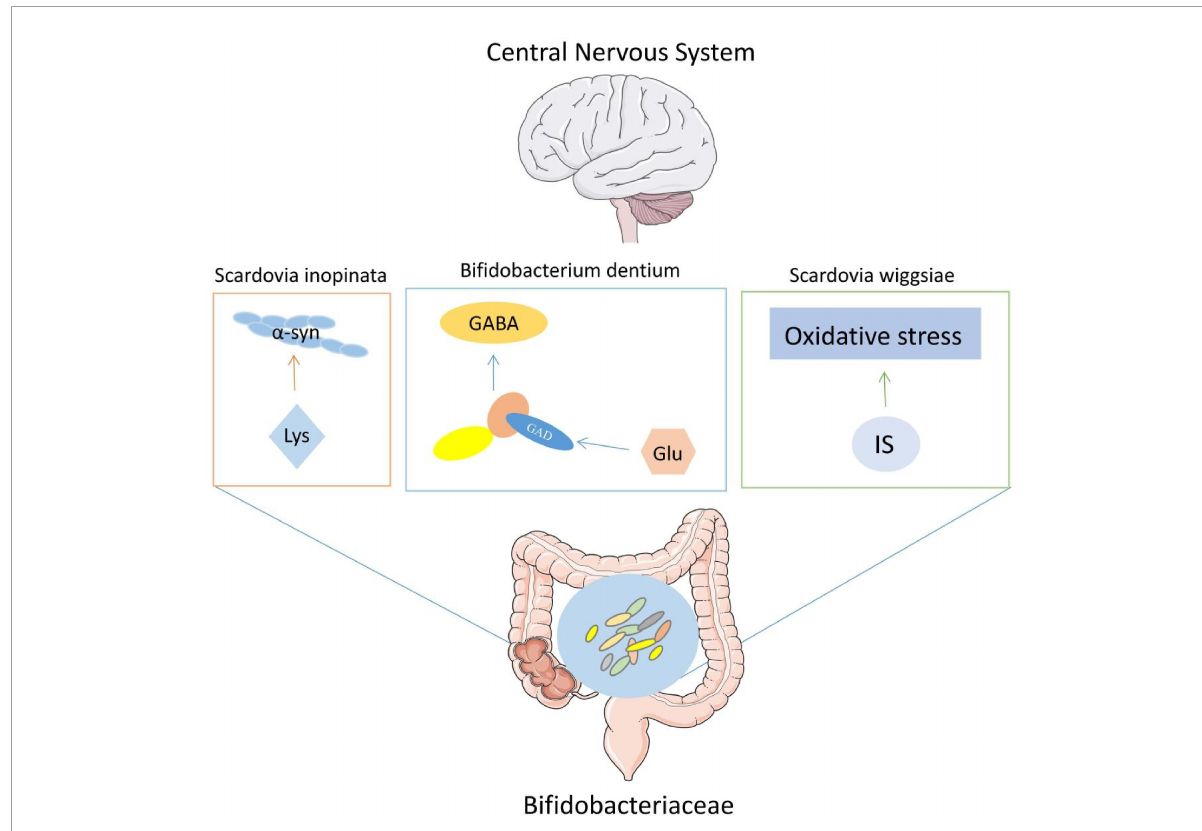
FIGURE5 An overview of the pathogenesis of three species from Bifidobacteriaceae in Parkinson’s disease (PD).